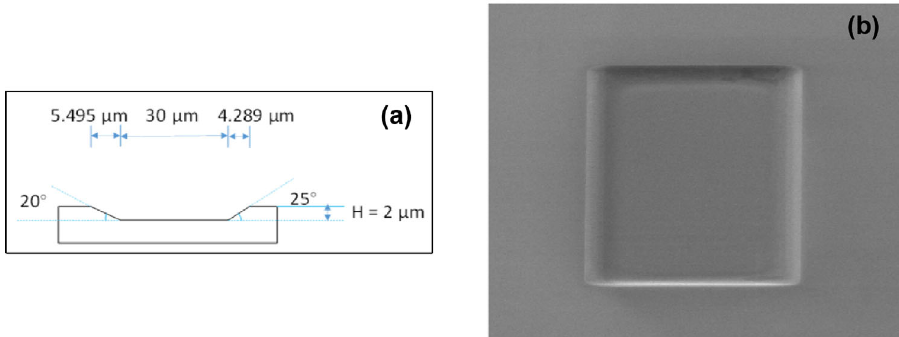
Fig. 1 Calibration grating after the FIB etching: (a) specific size of the grating; (b) SEM image of the calibration